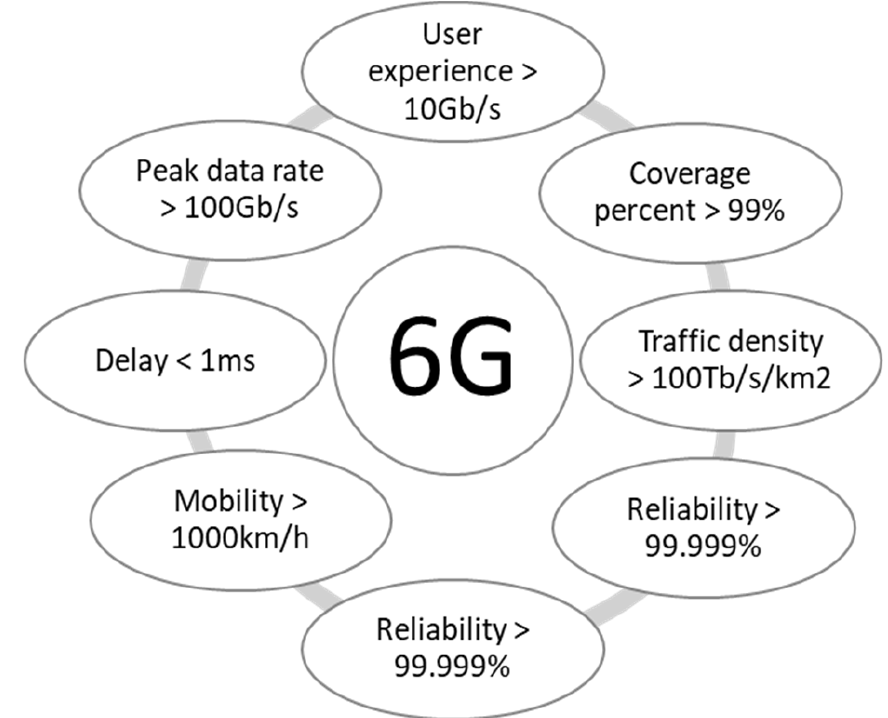
Figure 1. Possible capabilities of 6G.